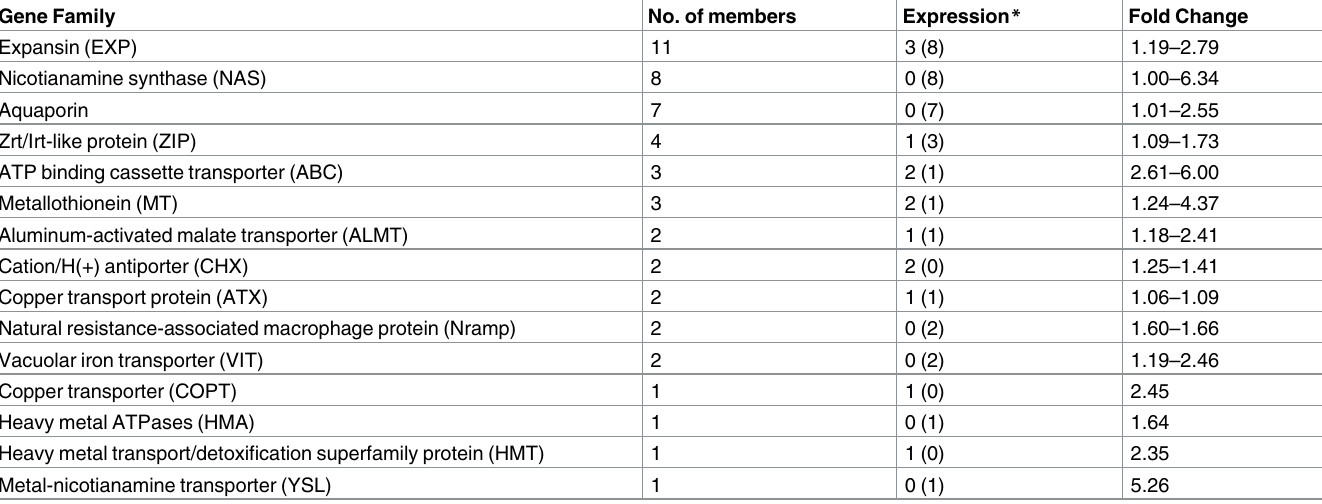
Table 3. Gene families related to heavy metal enrichment in P . americana